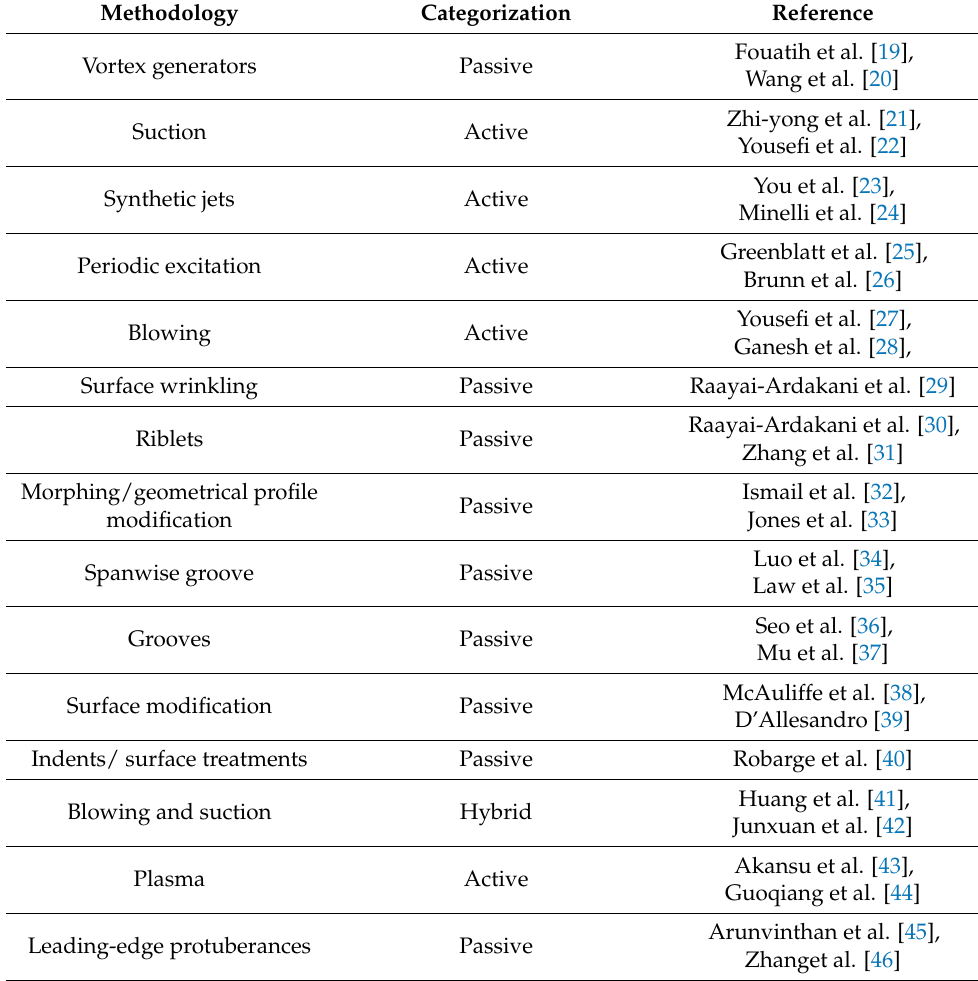
Table 1. Flow control